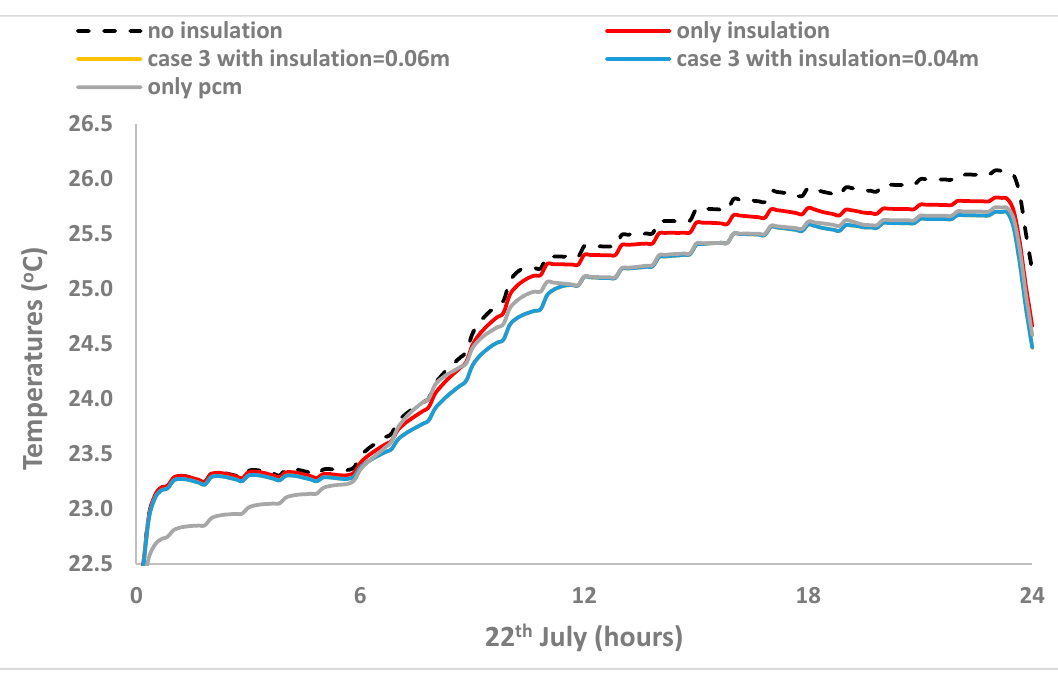
Figure 10. The temperature’s fluctuation for different cases on the coldest day of the year (12 January).